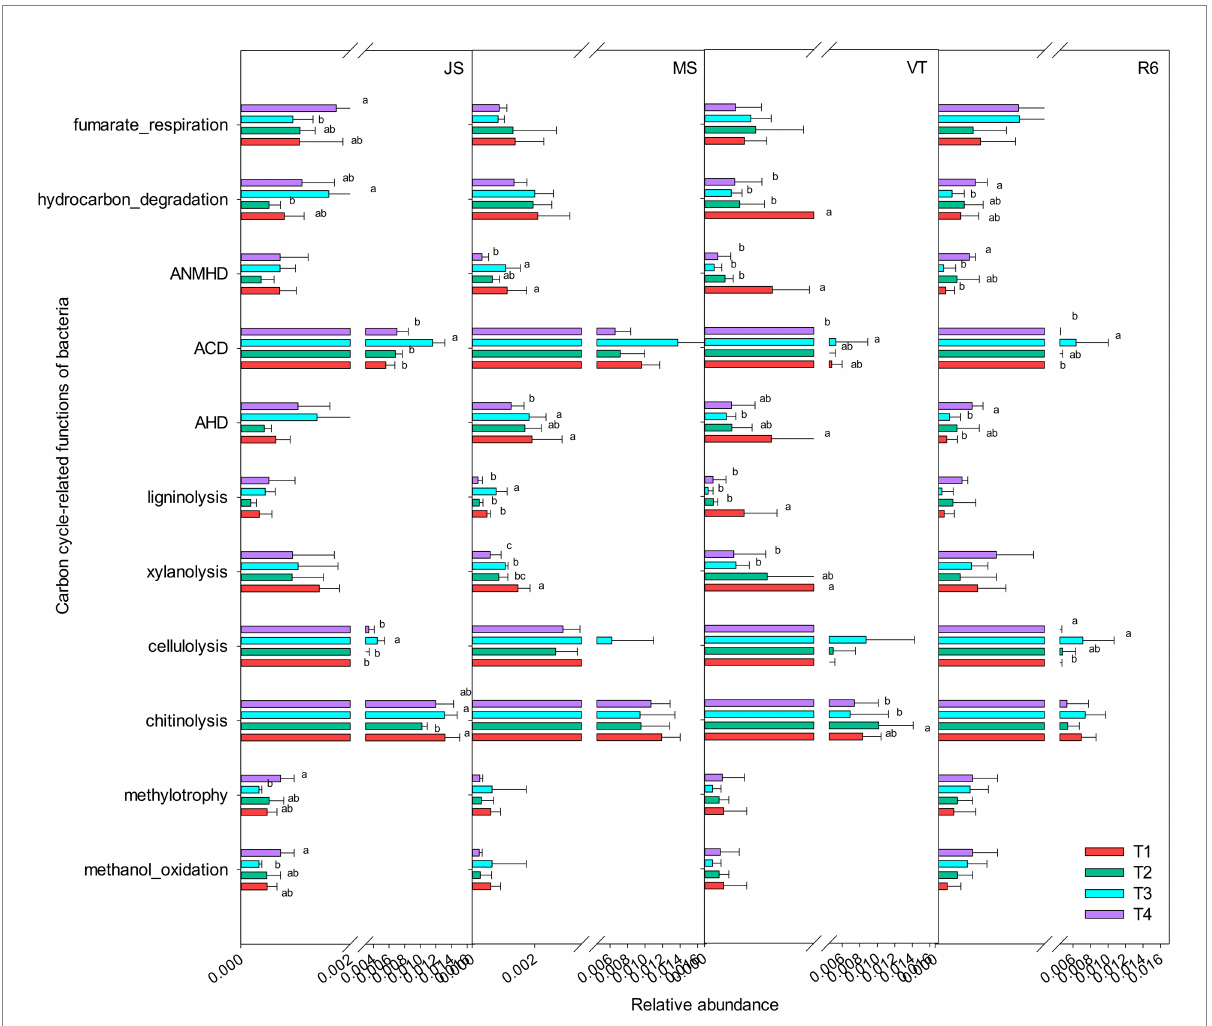
FIGURE 3 Carbon cycle-related functions of the bacterial communities as predicted by FAPROTAX. AHD, aromatic hydrocarbon degradation; ACD, aromatic compound degradation; ANMHD, aliphatic non-methane hydrocarbon degradation. Different letters represent significant differences ( p < 0.05). JS, jointing stage of wheat; MS, maturity stage of wheat; VT, tasseling stage of maize; R6, maturity stage of